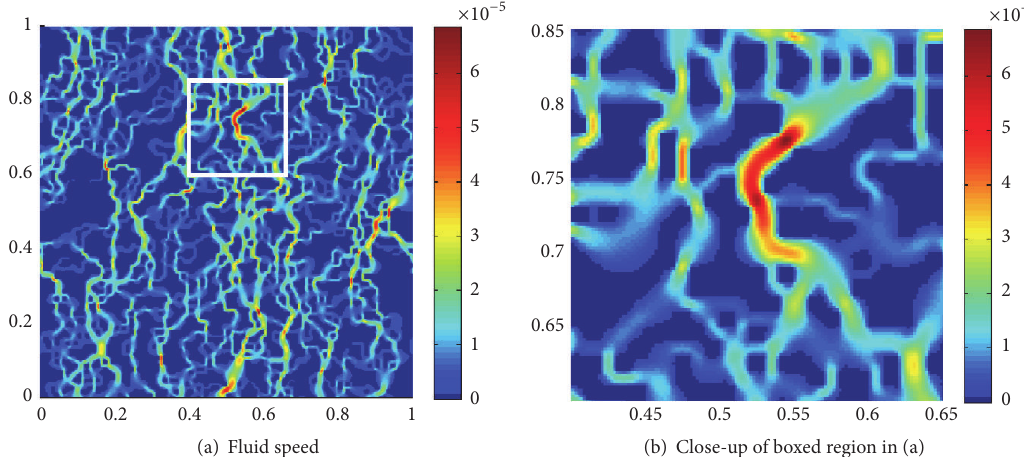
Figure 17: Flow (driven by 𝑔 𝑦 ) through randomly distributed squares, 𝜙 = 0.70 . Nondimensional fluid speed is indicated by color. Zero speed at solid sites is kept as dark blue for clarity of illustration (while these fluid speeds do not actually exist).